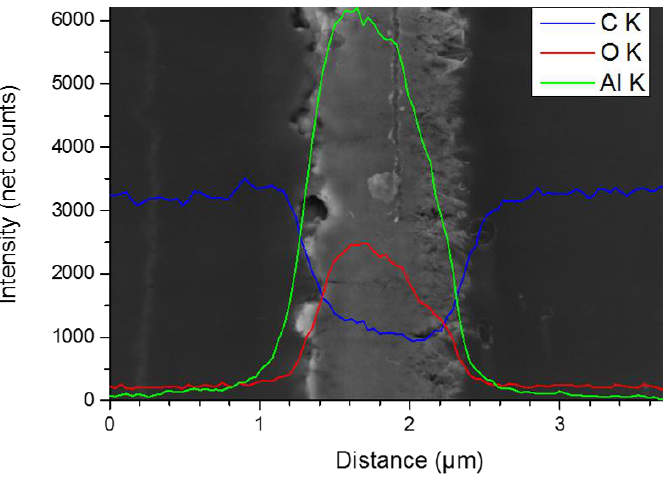
Figure 6. 3 kV SEM micrograph of the cross-section of EP1 (left) / HydBo / EP2 (right) and a 20 kV Energy Dispersive X-ray Spectroscopy (EDS) linescan with C K, O K, and AL K signals as net intensities (after spectral background subtraction). The EDS linescan has been extracted from a 256 × 196 pixel hypermap (Appendix D) over the imaged area and after summing all of the net X-ray intensities along the direction parallel with the HydBo layer in order to get good counting statistics under gentle excitation conditions.